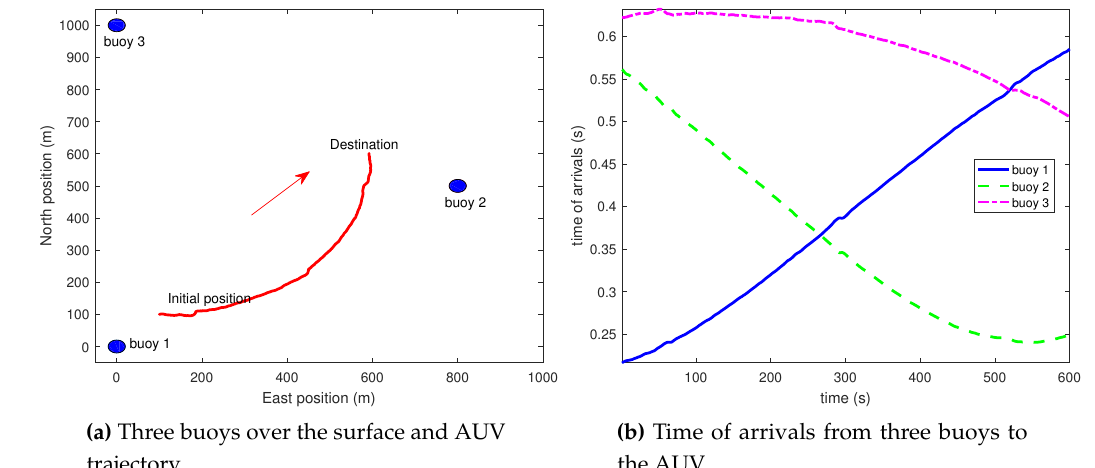
Figure 3. Time of arrivals considering the sound speed